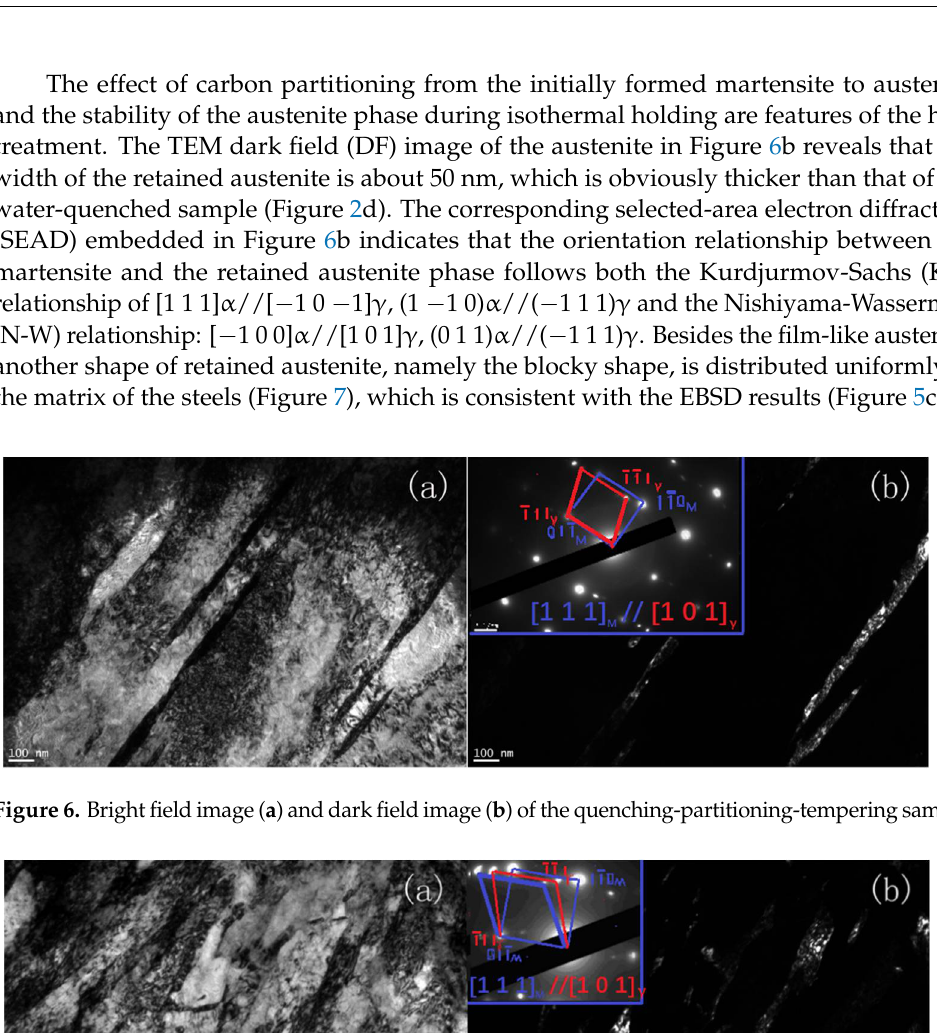
Figure 5. The electron backscattering diffraction analysis ( a ) overall image quality (IQ) map, ( b ) bcc phase inverse pole figure (IPF) map, and ( c ) phase map of sample quenched to 220 °C and parti- tioned-tempered at 400 °C for 60 s.